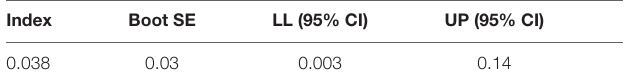
TABLE 7 | Index of mediation